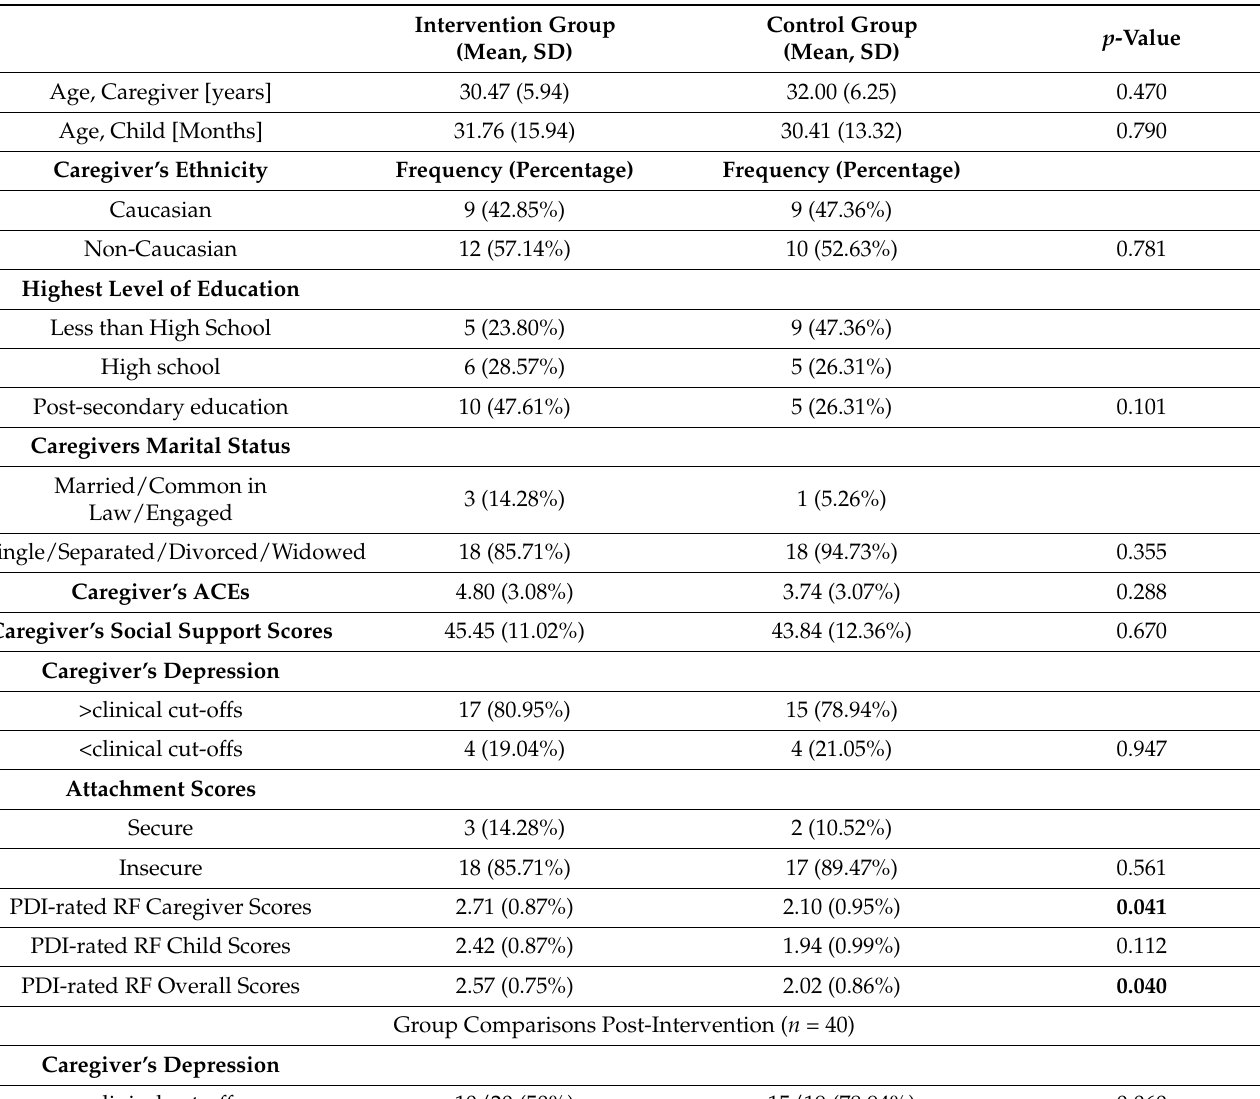
Table 2. Group Comparisons at Baseline ( n =